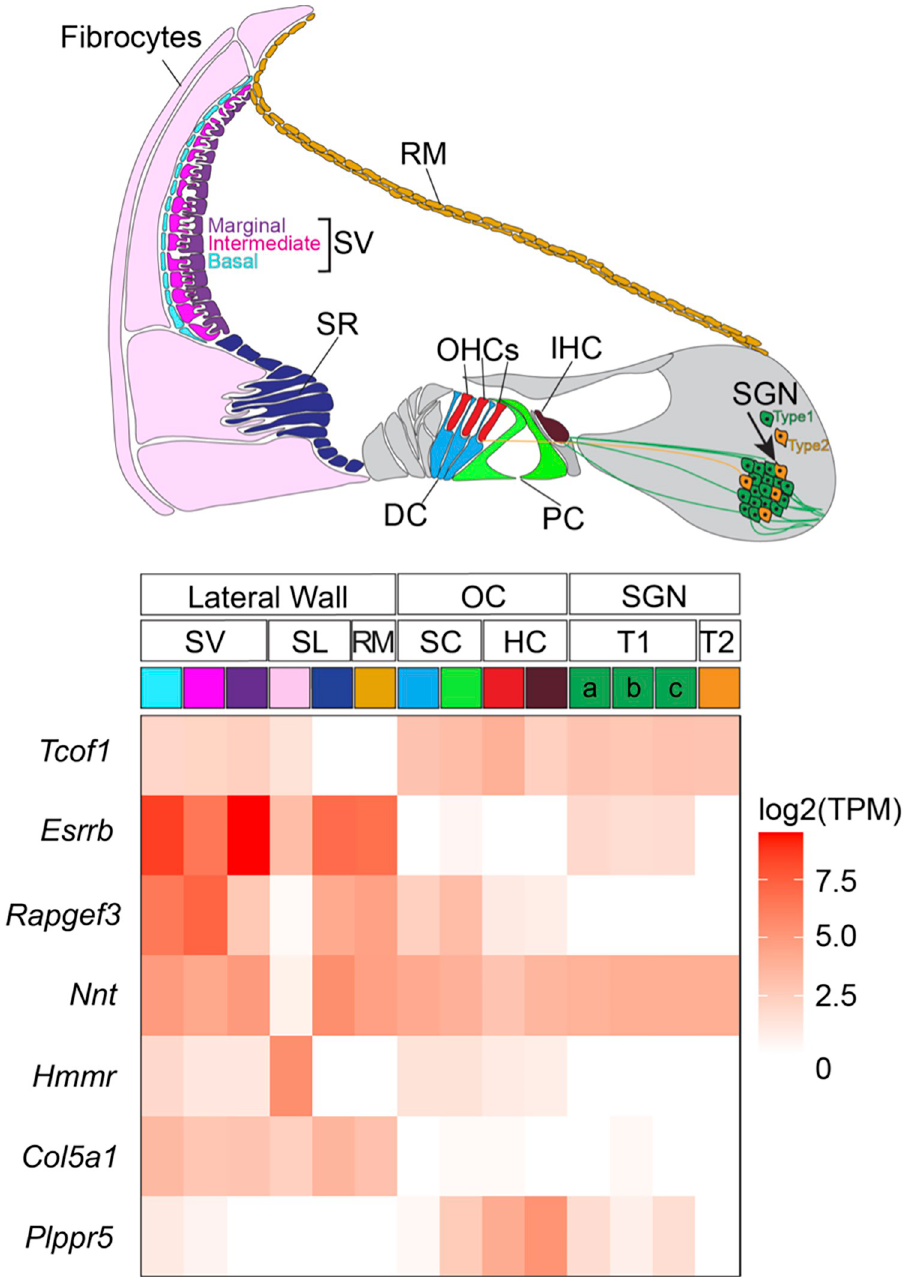
Fig 5. Expression of genes identified in our study in specific cell types from a representative transverse section through the mouse cochlea. The heat map was generated from previously published bulk and single cell RNA-seq datasets deposited in the gEAR portal (https://umgear.org/). Abbreviations: Deiters’ cells (DC), hair cells (HC), inner hair cell (IHC), outer hair cells (OHCs), pillar cells (PC), Reissner’s membrane (RM), spiral ganglion neurons (SGN) Type 1 (T1) and Type 2 (T2), spiral ligament (SL), spindle-root cells (SR), stria vascularis (SV), support cells